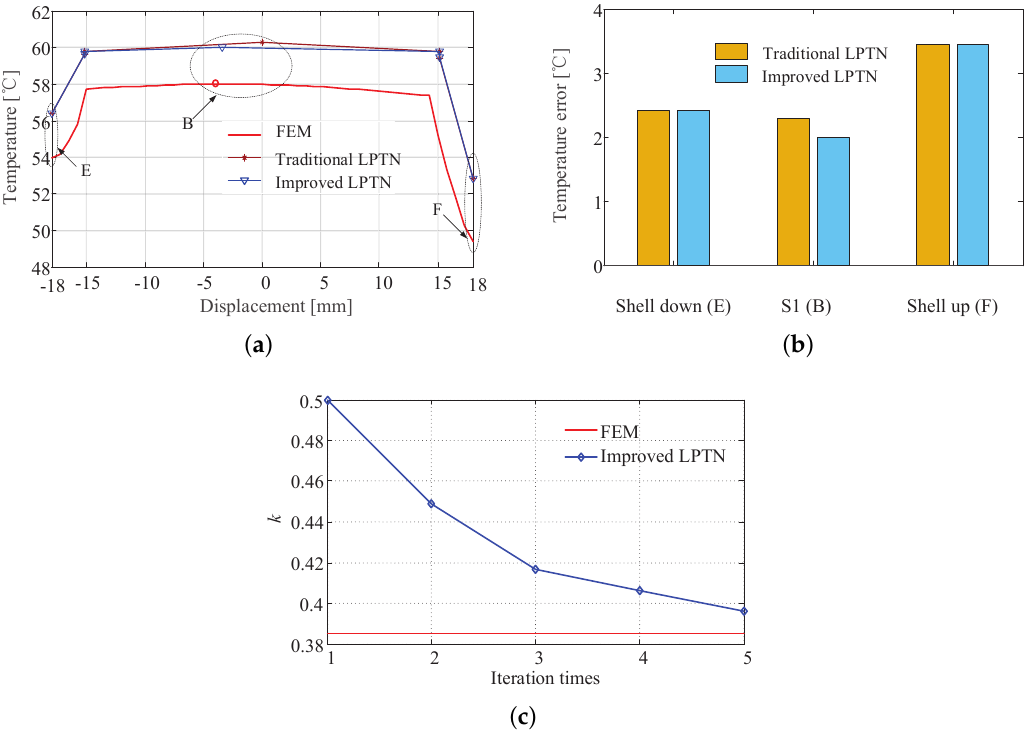
Figure 14. ( a ) Temperature distribution in z direction at 15 A. ( b ) Temperature error at several points. ( c ) Curve of correction factor k with iterations.